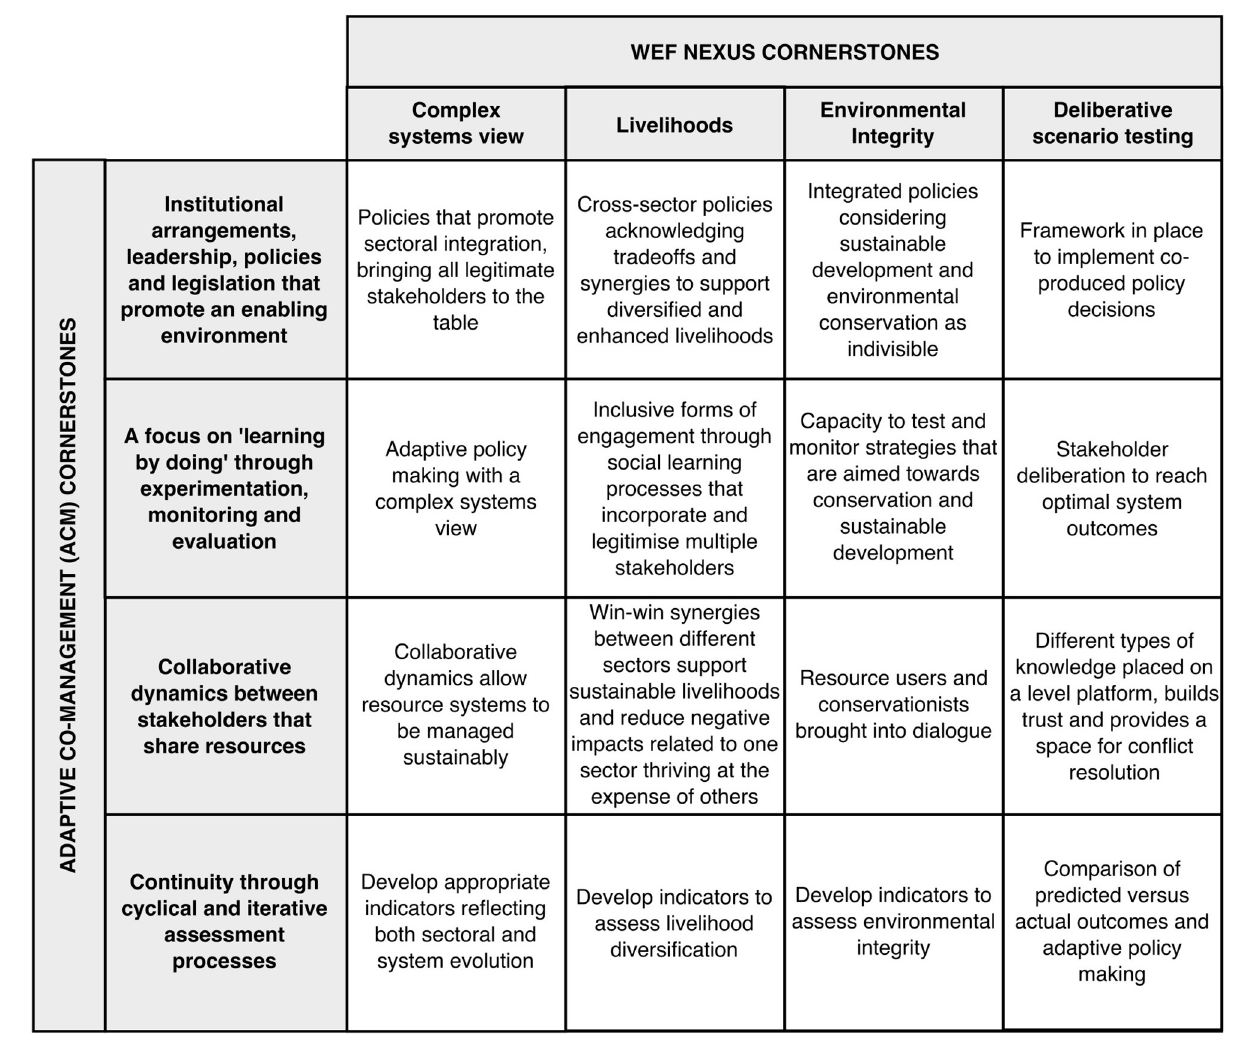
FIGURE 1 | WEF-ACM Matrix: WEF nexus cornerstones intersected by adaptive co-management (ACM) cornerstones. Source: The